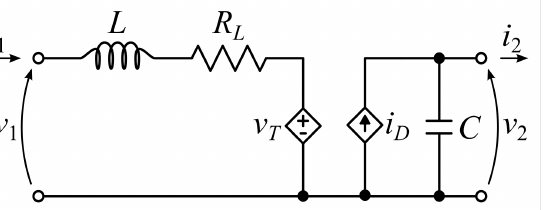
Figure 7. Circuit model of a DC–DC converter considering Joule and conduction losses in the